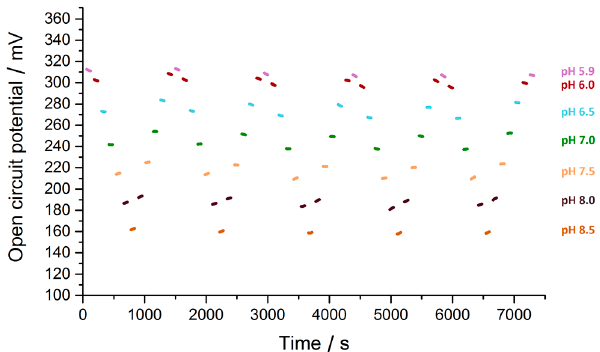
Figure 18. pH value series from pH 5.9 to pH 8.5 in steps of 0.5 for an iridium oxide electrode vs. an Ag/AgCl reference electrode. One minute of open circuit potential recording followed by one minute to change the pH solution and allow the sensor some time to adapt to the new solution. Data recorded using the custom made electronics.